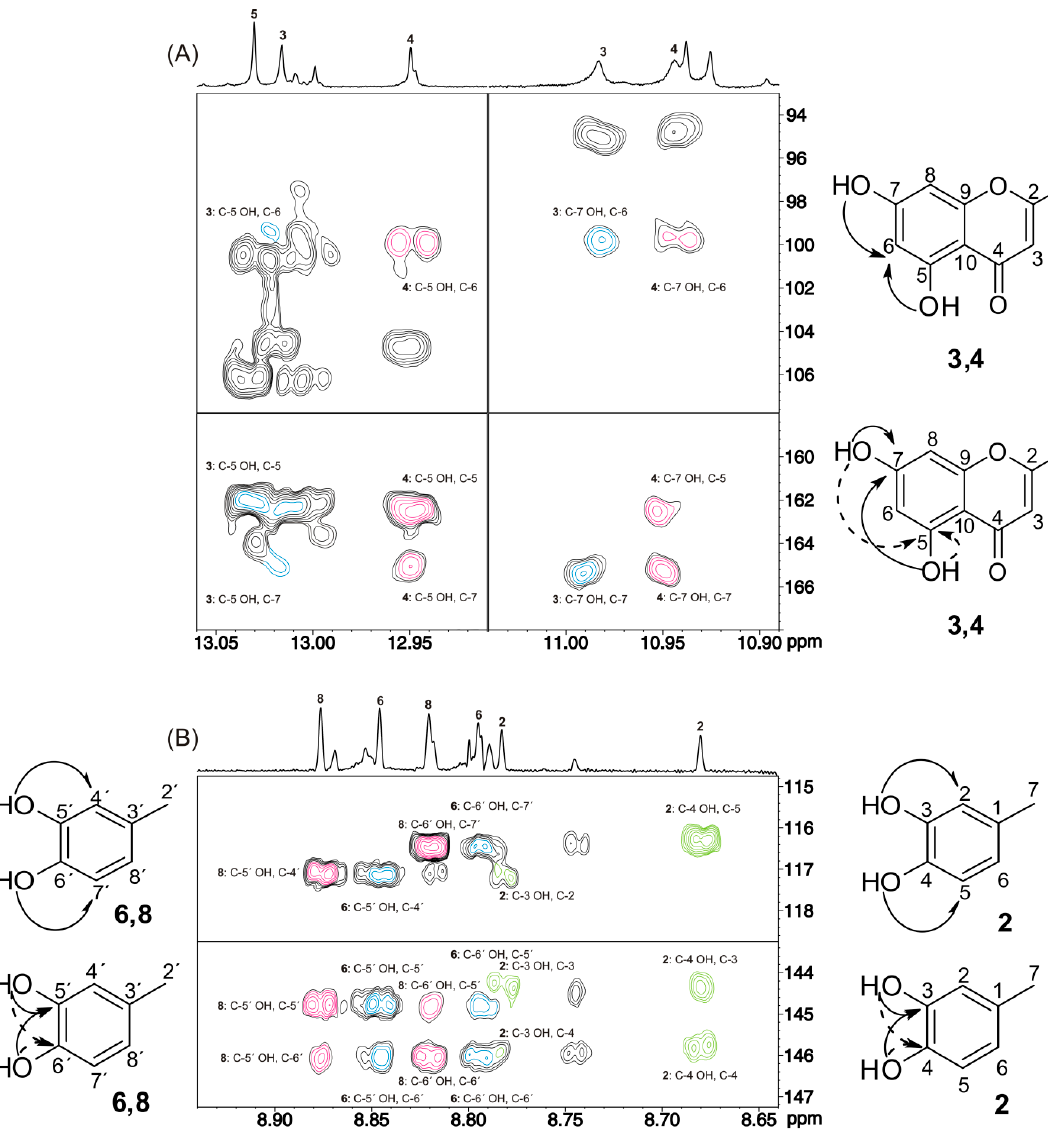
and the common cross-peaks of the C-5 and C-7 OH groups to C-6 (99.42 ppm) and C-7 (165.01 ppm) of luteolin ( 3 ) are of diagnostic value (Figure 23A). Figure 23. 500 MHz 2D 1 H- 13 C HMBC-NMR spectrum of 10 mg of an olive leaf methanol extract in 0.6 mL of DMSO- d with a mass ratio of [picric acid]/[extract] 6 of 49.3 × 10 − 3 (T = 288 K, number of scans = 88, experimental time = 11 h and 34 min). The experiment was optimized for n J ( 1 H, 13 C) values of 6 to 8 Hz. ( A ) The common cross-peaks of the C-5 and C-7 hydroxyl protons to carbons C-6, C-5, and C-7 of luteolin-4 ′ - O - β - D -glucopyranoside ( 4 ) and the common cross-peaks of the C-5 and C-7 hydroxyl protons to carbons C-6 and C-7 of luteolin ( 3 ) are illustrated in red and blue, respectively. ( B ) The common cross-peaks of the C-5 ′ and C-6 ′ hydroxyl protons to carbons C-4 ′ and C-7 ′ , respectively (upper trace), and the common cross-peaks to carbons C-5 ′ and C-6 ′ (lower trace) are illustrated in blue for oleuropein 6- O - β - D -glucopyranoside ( 6 ), green for hydroxytyrosol ( 2 ), and red for oleuropein (aldehyde form) ( 8 ). Reproduced with permission from [16]. Copyright 2011, by the American Chemical